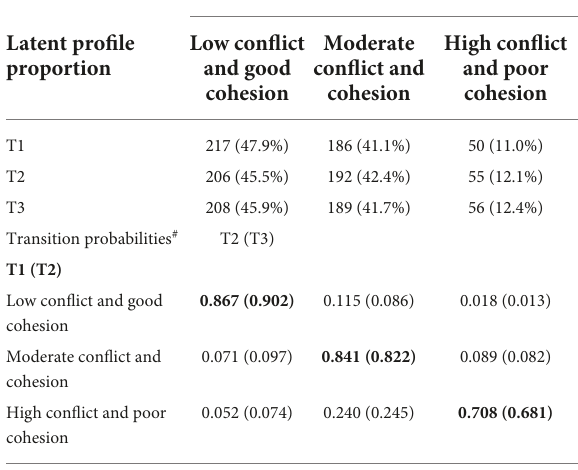
Changes in profiles for perceived